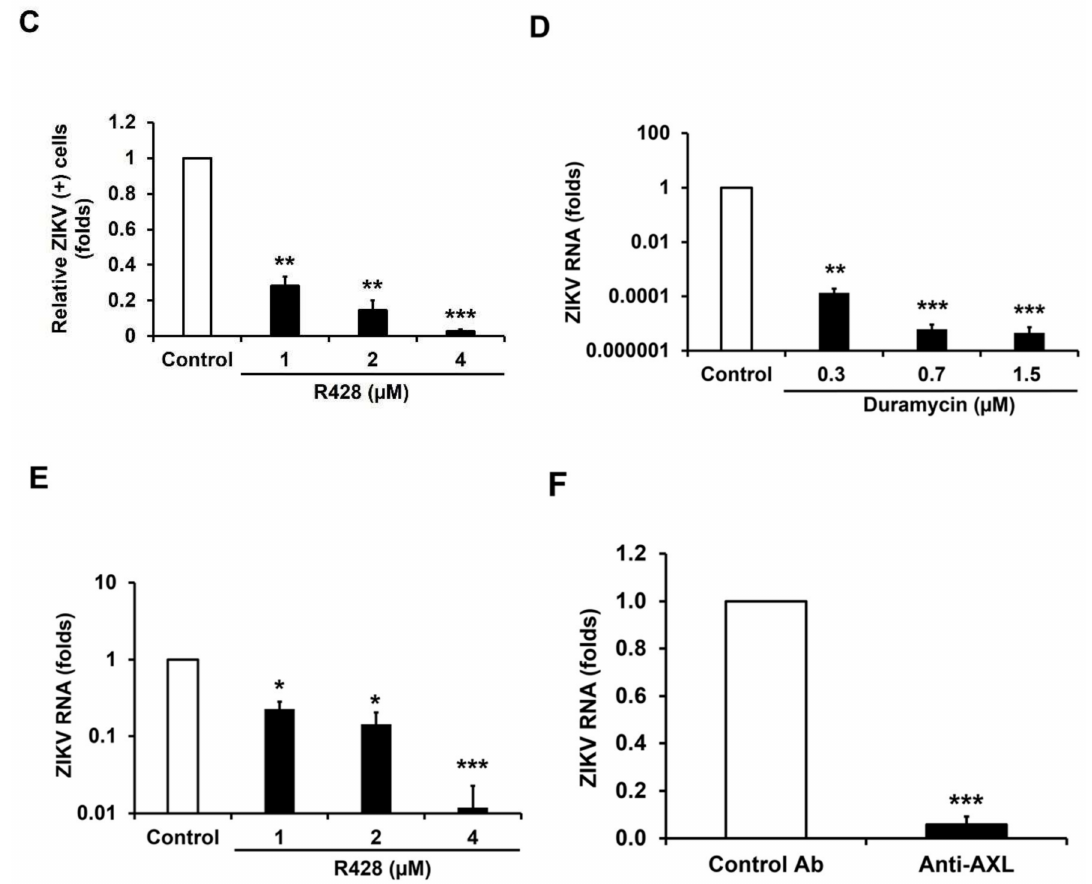
Figure 1. HFAs are highly permissive for ZIKV infection. ( A ) HFAs and A549 cells were infected with PLCal ZIKV (MOI = 3) for 1–5 days and virus replication was quantitated by measuring genomic RNA in cells using qRT-PCR. ( B – E ) Cells were infected with ZIKV that had been pre-incubated with duramycin for 1 h or first treated with R428 for 1 h followed by infection with ZIKV (MOI = 0.5). One day later, cells were processed for indirect immunofluorescence using antibodies against flavivirus envelope protein or total RNA was harvested for qRT-PCR. ( B , C ) Data from automated quantitation of ZIKV-positive cells. ( D , E ) Quantification of ZIKV replication by qRT-PCR after drug treatment. ( F ) HFAs were pre-incubated with anti-AXL blocking antibody for 1 h followed by ZIKV infection (MOI = 10). After 24 h, cells were collected and viral RNA was quantified by qRT-PCR. The means of three independent experiments are shown. Error bars represent standard error of the mean. * p < 0.05, ** p < 0.01, *** p < 0.001 (Student’s t